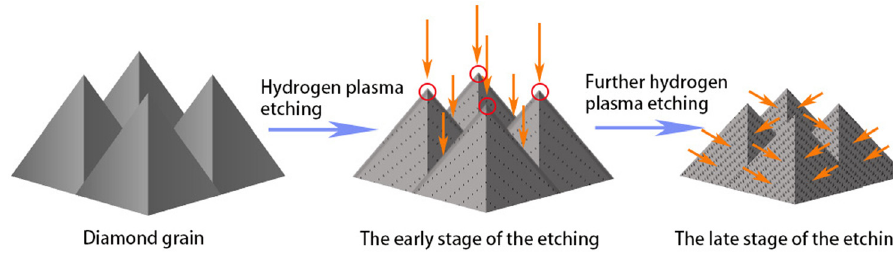
Figure 2: Plasma etching diamond fi lm fl attening process